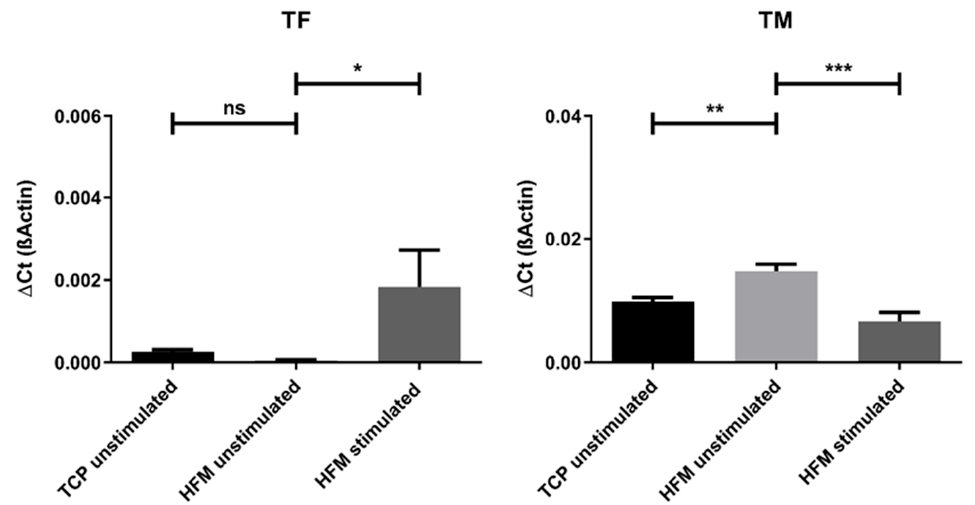
Figure 3. Gene expression analysis for the assessment of the inflammatory and thrombogenic genotype of pCECs on HFMs. Expression levels of the inflammatory (E-Selectin and ICAM) and thrombogenic state (TM and TF) marker genes were compared between untreated pCECs on TCP versus HFMs and pCECs on HFMs stimulated with TNF α . A one-way ANOVA with correction for multiple comparisons (Šídák test) was used to compare these three groups as indicated in the figure. TCP: Tissue Culture Plastic; HFM: Hollow Fiber Membrane; stimulated: six hours of TNF α exposure; unstimulated: control group without TNF α exposure. Results are given as mean with SD ( n = 3) (* p < 0.05; ** p < 0.01; *** p < 0.001; ns = no significance).